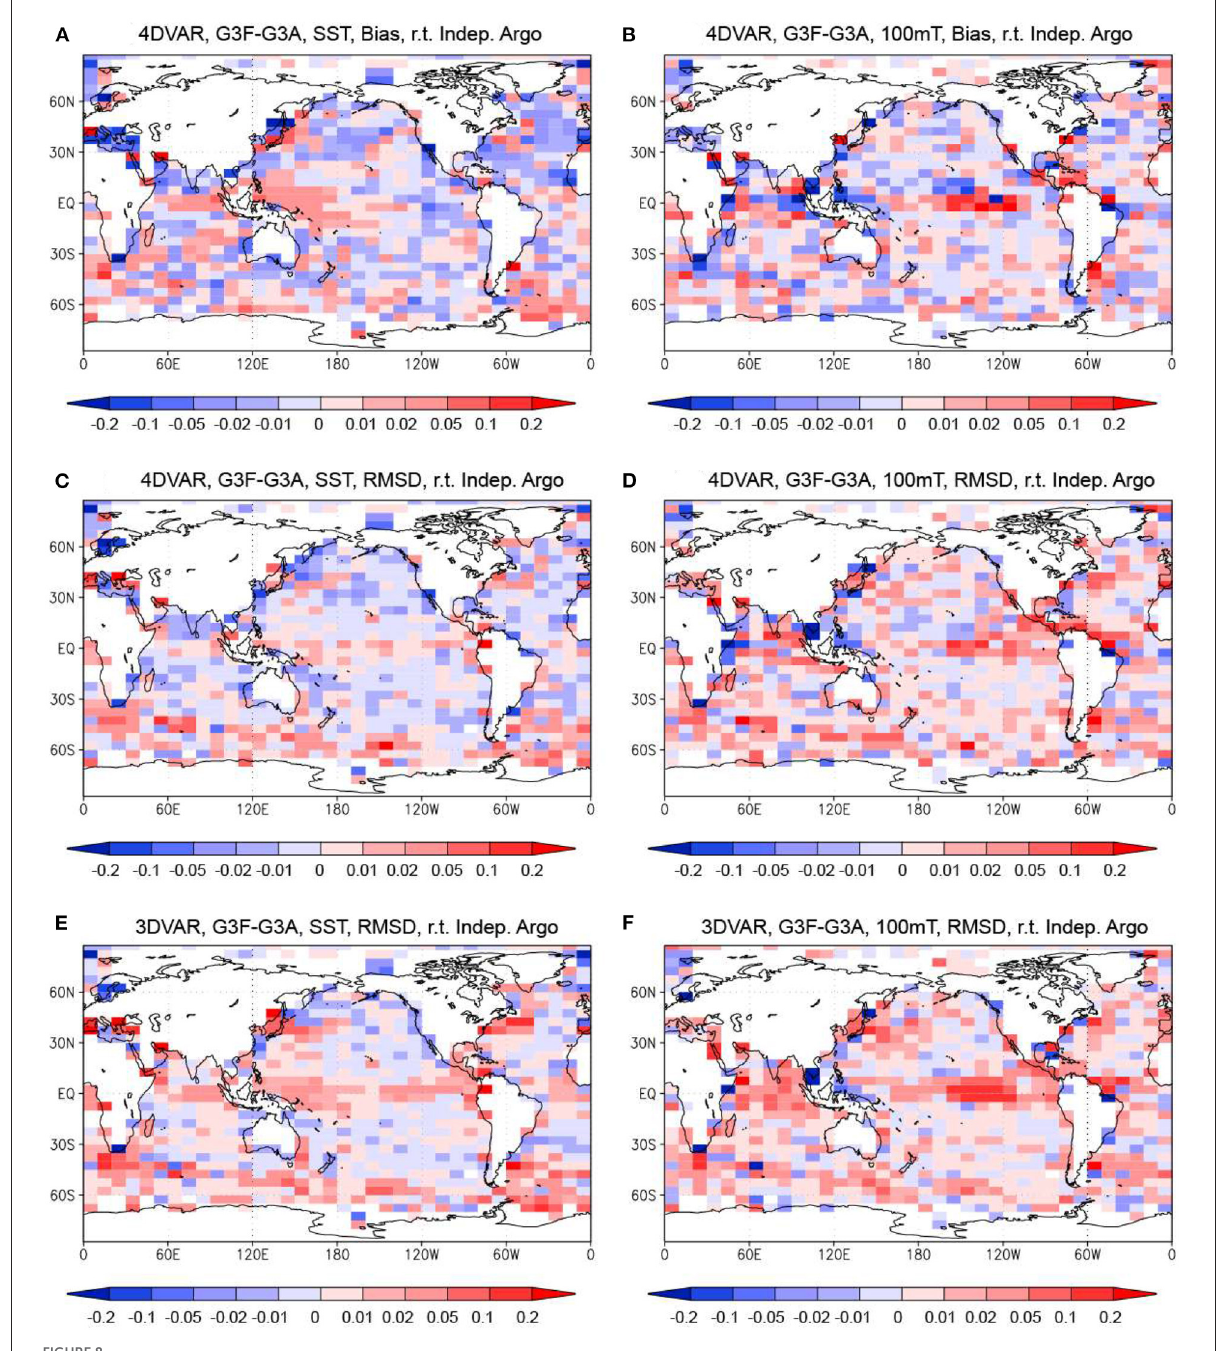
FIGURE8 Difference of the bias absolute values and the RMSDs relative to the independent Argo float data between the MOVE-G3A and MOVE-G3F temperature in the 4DVAR and 3DVAR Runs. (A, B) Difference of the bias absolute values at the surface and 100m depth in the 4DVAR Run. (C, D) Difference of the RMSDs at the surface and 100m depth in the 4DVAR Run. (E, F) Same as (C, D) but for the 3DVAR Run. Blue colors mean that the bias absolute value or the RMSD is smaller for the MOVE-G3F temperature. Units in ◦ C.